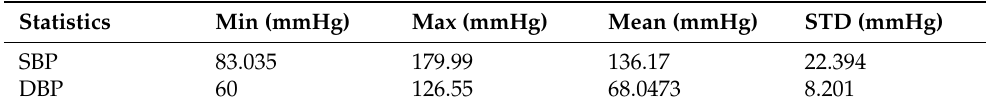
Figure 4. Histogram of blood pressure distribution: ( a ) is the data distribution of SBP; ( b ) is the data distribution of DBP. distribution of DBP. Table 1. Statistics of SBP and DBP in data Table 1. Statistics of SBP and DBP in data set.